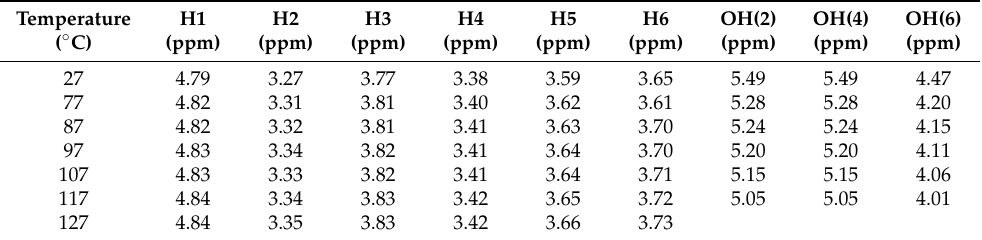
Table 1. Chemical shifts of α -CD in an IC conjugated with AuNPs at various temperatures. Temperature H1 H2